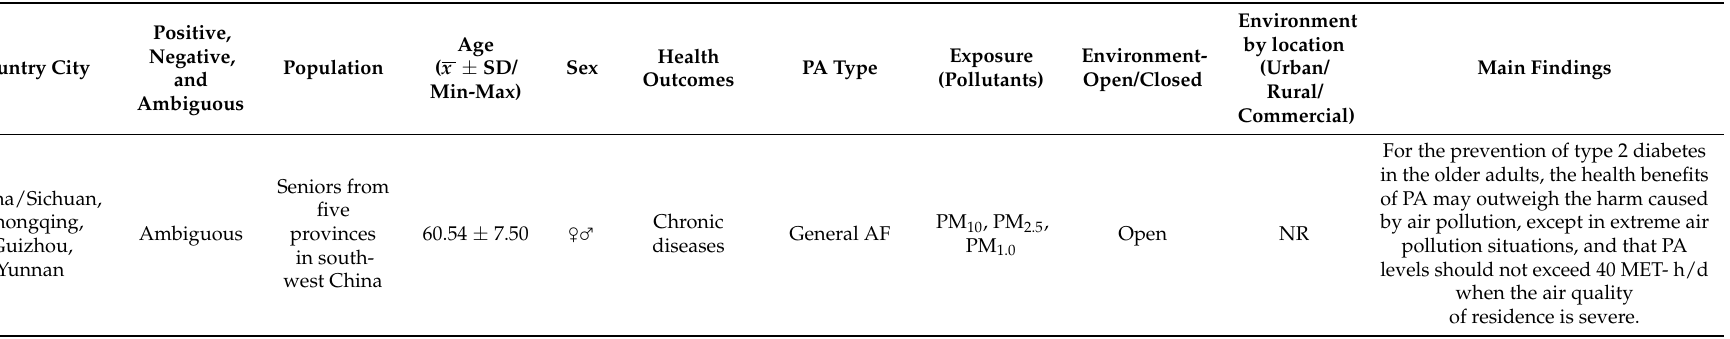
Table 6. Sample characteristics (sex and age), pollutants, physical activity, health outcomes, and ambiguous findings about pollutants in the health of older adults during